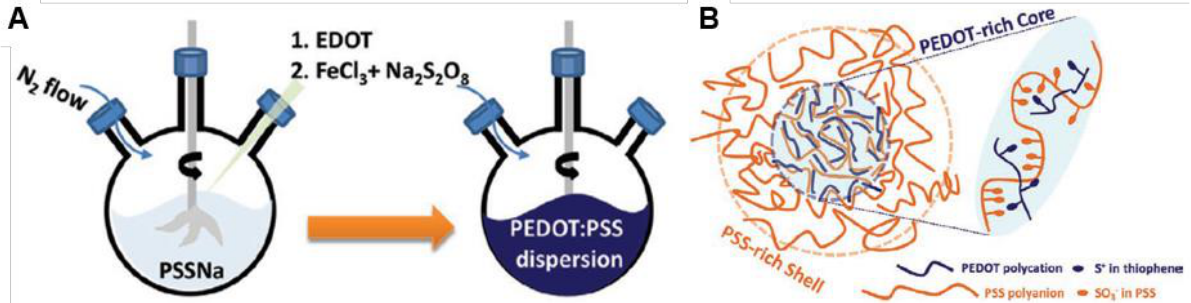
Figure 4. Scheme of PEDOT:PSS structure ( A ). Scheme of PEDOT:PSS polymerization ( B ). Adapted with permission from